Question: State the chart type depicted above.
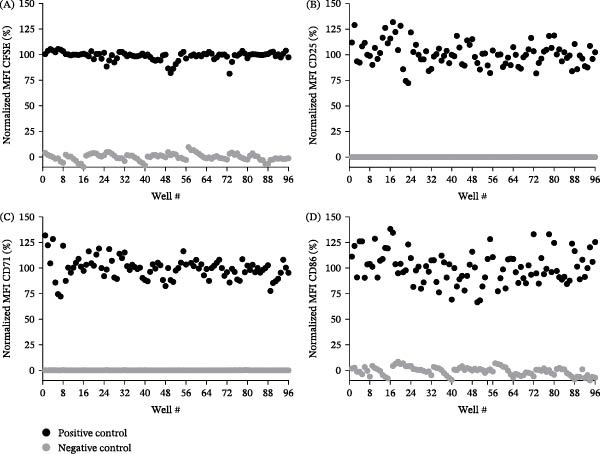
Answer: scatter